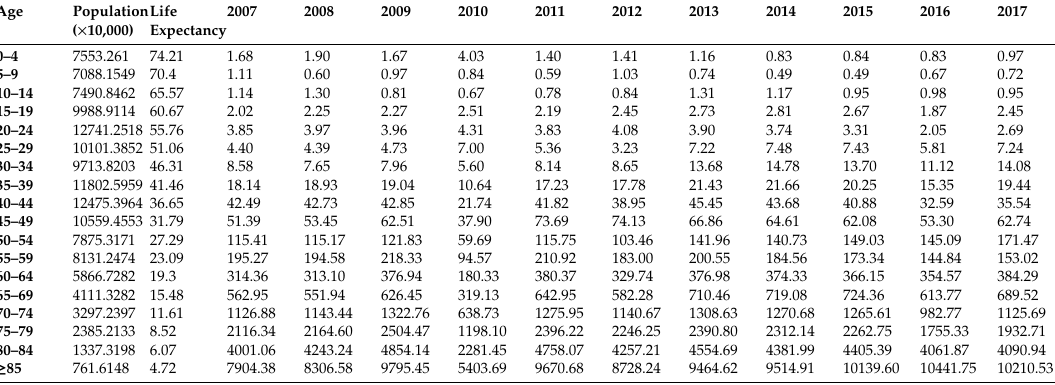
Table A5. Population, life expectancy and cardiovascular disease mortality (1 / 100,000) of all age groups Age Population Life ( × 10,000)